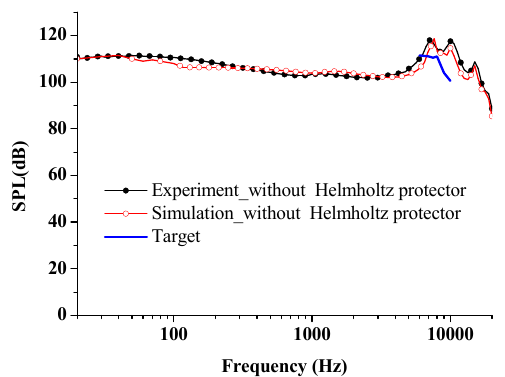
Figure 18. Experimental and simulated results (without Helmholtz protector).